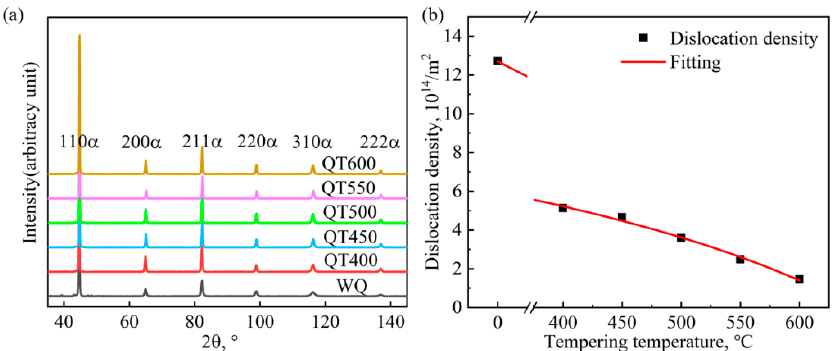
Figure 6. ( a ) XRD patterns, ( b ) dislocation density of the specimens after different heat treatments.